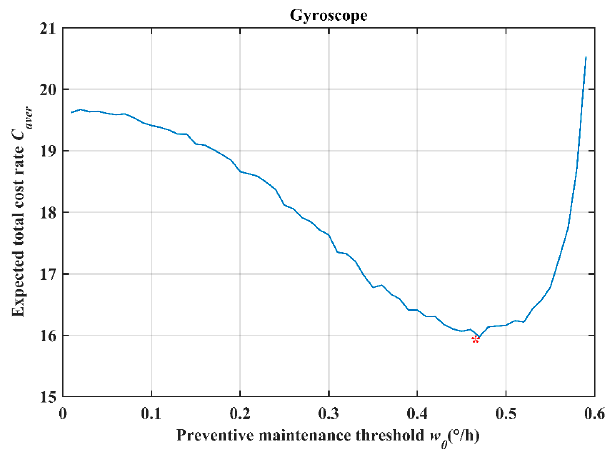
Figure 4. Total expected cost rate 𝐶 (cid:3028)(cid:3049)(cid:3032)(cid:3045) versus the PM threshold 𝑤 (cid:2868) when 𝑞 = 0.90 .